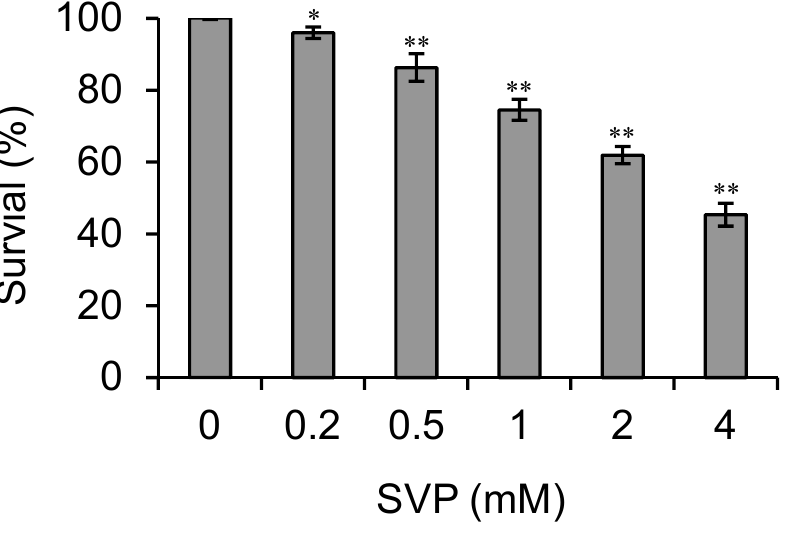
Figure 1. Effects of SVP on proliferation of Bel-7402 cells. Human hepatocarcinoma Bel-7402 cells were treated with different concentrations of SVP for 24 h, and cell viability was evaluated by CCK-8 assay. Data shown are representative of three independent experiments. * p < 0.05, versus control group. ** p < 0.01, versus control